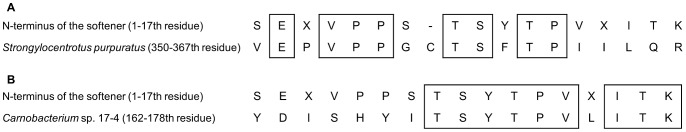
Comparison of amino acid sequences between the softener and other known proteins by BLAST.In N-terminal amino acid sequence of the softener, third X residue means unidentified residue and 14th X residue means proline or phenylalanine. The third residue was excluded in calculation of the identity. Identical residues were boxed. (A) Sequence comparison between the softener and partial amino acid sequence of ubiquitin carboxyl-terminal hydrolase 34-like protein from Strongylocentrotus purpuratus (XP_785288.3) that showed the highest bit score among echinoderms. Identity was 47.1%. (B) Sequence comparison to partial amino acid sequence of GntR family transcriptional regulator from Carnobacterium sp. 17-4 (YP_004375176.1) that showed the highest bit score among whole organism. Identity was 56.3%.